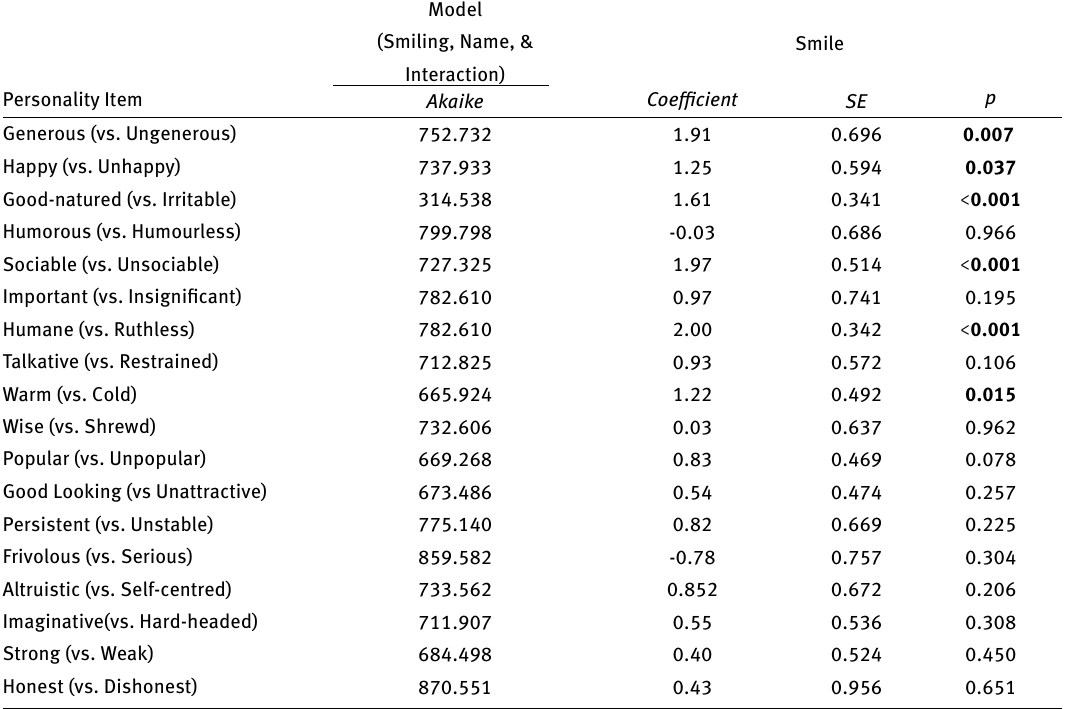
Table 1: Effect of robot smiling on participant perceptions of robot personality